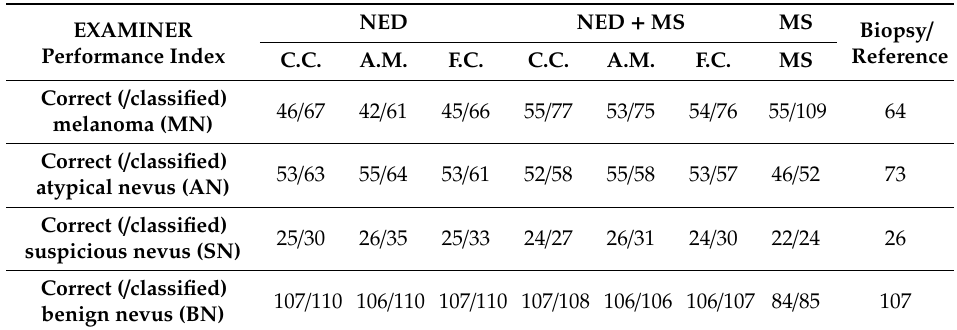
Table 7. Comparison of lesion classification by non-expert (NED) dermatologist group and semi-automatic approach (NED + MS).